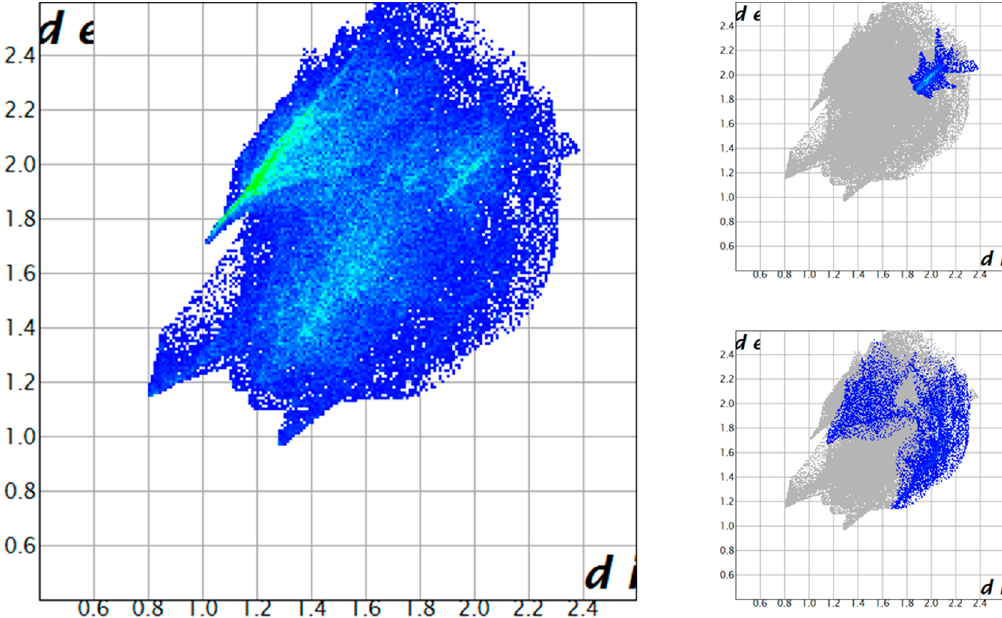
Figure 9. (H 2 L-Ts) 2+ fingerprint plot. C-C contacts indicative of face to face π - π stacking and C-H wings are shown in top and bottom inset, respectively.